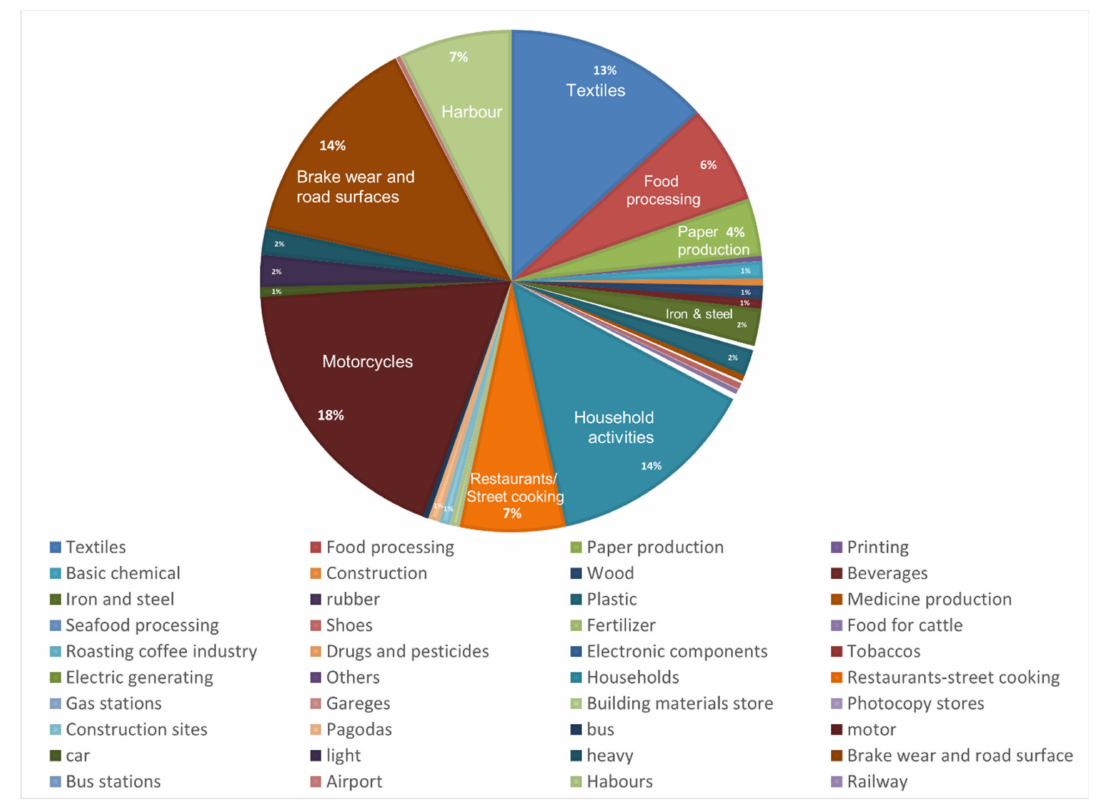
Figure 3. Source component of PM 2.5 in